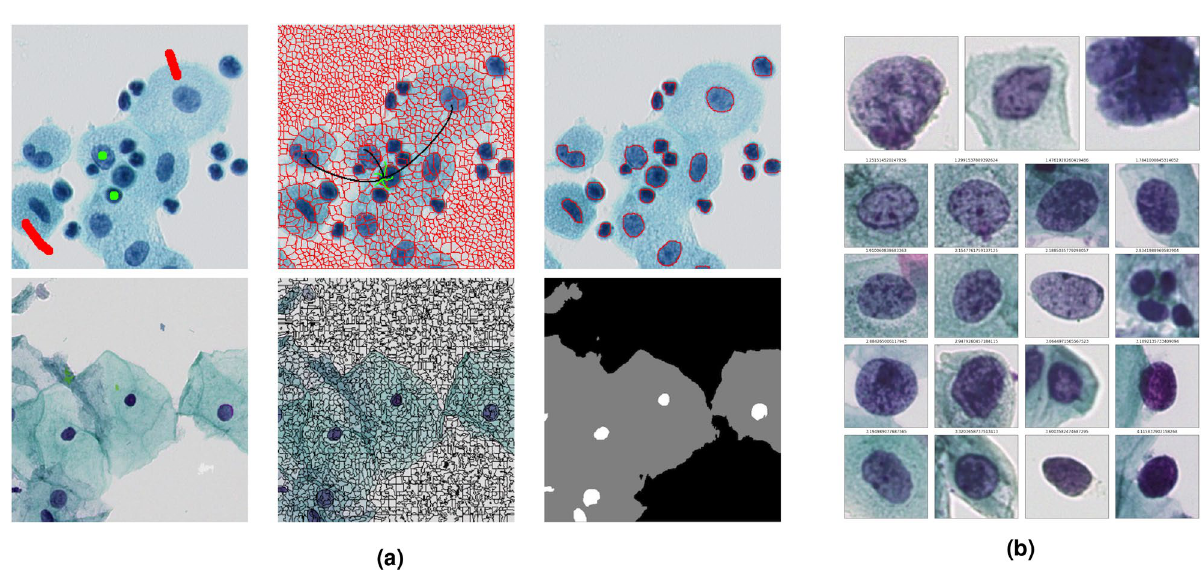
Figure 4. Applications in medical imaging. ( a ) Semi-supervised segmentation of cell images (from left to right: images with initial labels, superpixel segmentation and segmentation results. ( b ) Indexation using the eikonal equation (top: abnormal cells used as seeds; bottom: some indexed cells from the